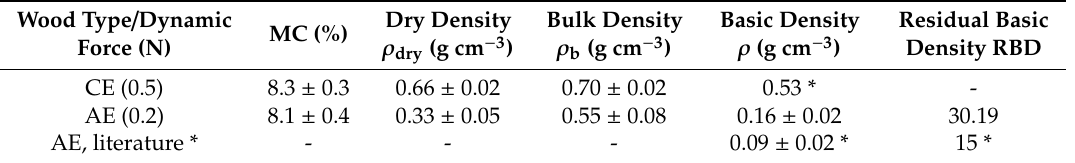
Table 1. Mean values ( ± standard deviations) of MC at the start of the measurement, bulk density ( ρ b ), basic density and dry density ( ρ dry ) of wood